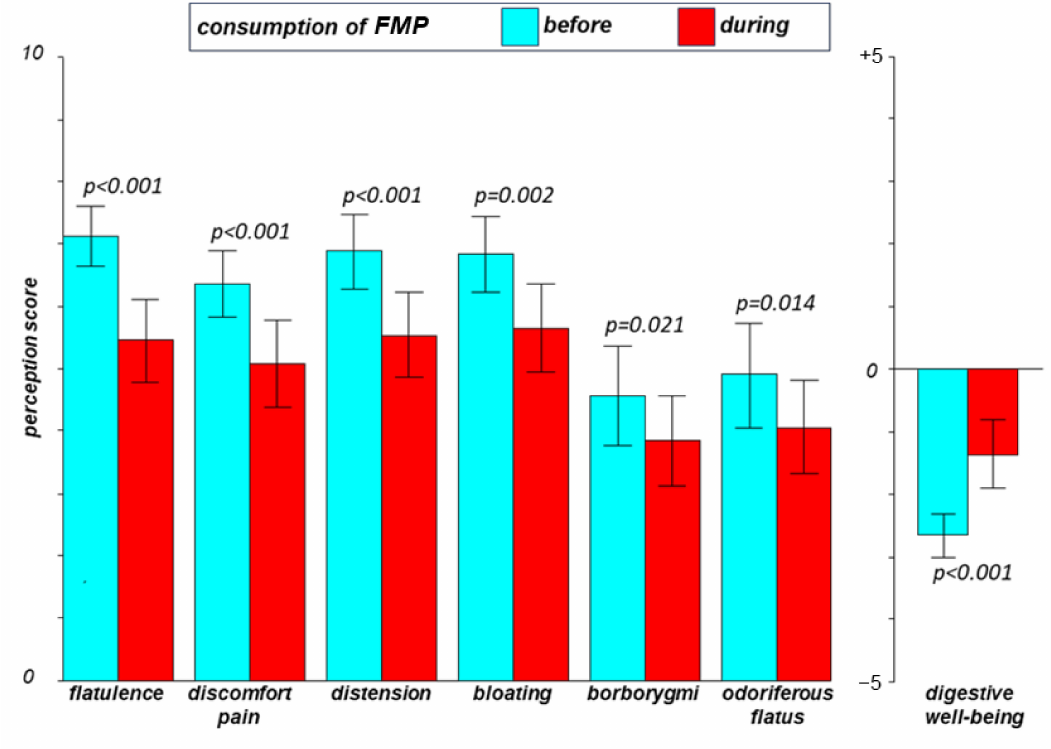
Figure 3. Effect of consumption of fermented milk product (FMP) on tolerance of a plant-based diet. Data are means [95% confidence interval]. Statistical comparisons were performed by Wilcoxon signed-rank test in each subject using the average of the last 2 days of evaluation periods (on the plant-based diet) before (days 17 and 18) and during FMP consumption (days 45 and 46: n =